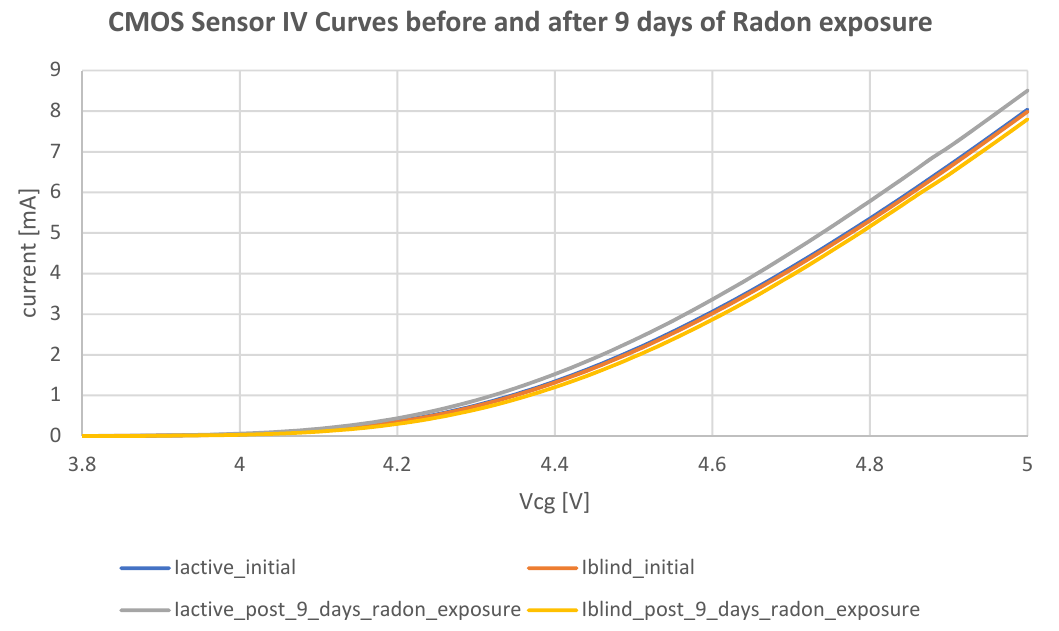
Figure 11. Readout voltage derivative.